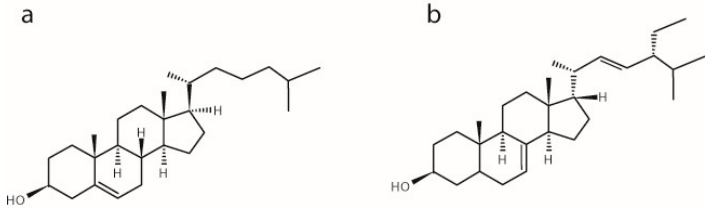
Figure 1. Chemical structures of ( a ) cholesterol and ( b ) α -spinasterol.